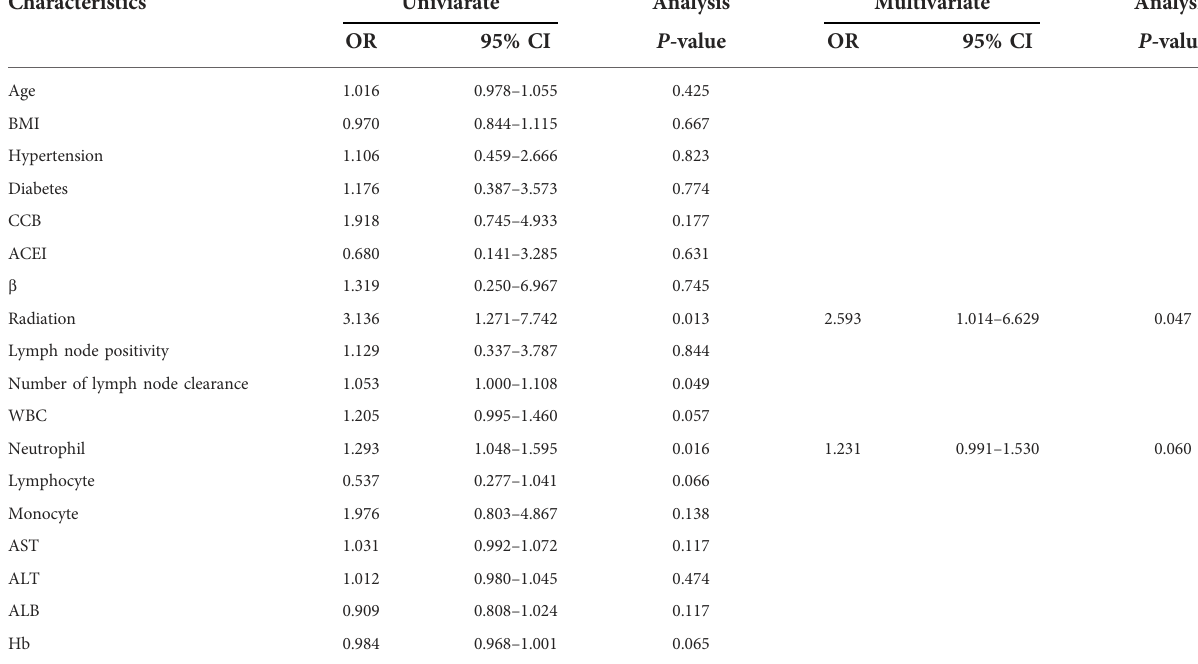
TABLE 3 Univiarate and multivariate analysis of cervical cancer for lymph